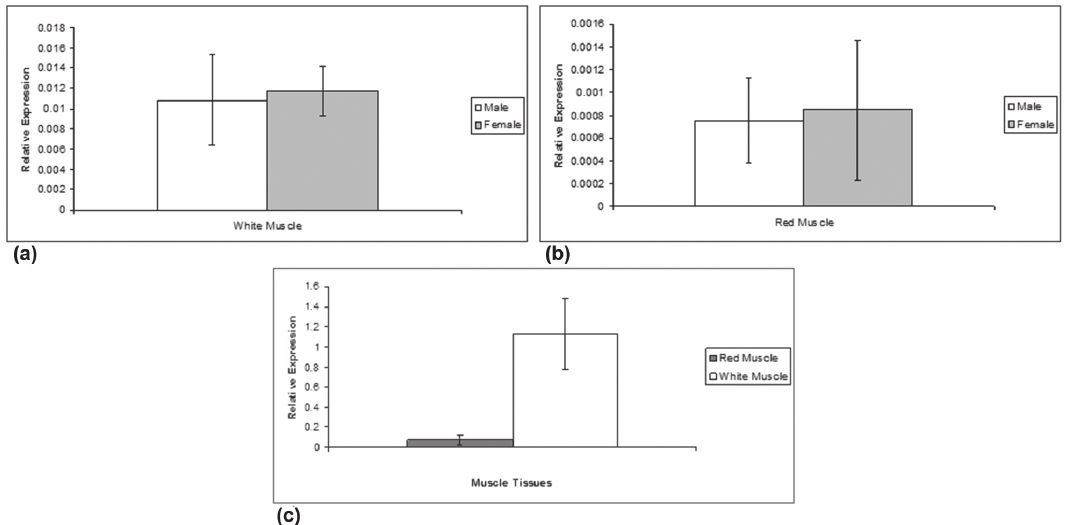
Figure 4 - Relative gene expression analysis of the α-skeletal muscle actin genes of white and red ( c ) muscle tissues of males and females ( a , b ) of Leporinus macrocephalus. Data were run in duplicate, and the constitutive 18S rRNA gene (18S), was used as a control. Normalized data were expressed as means ± SD.